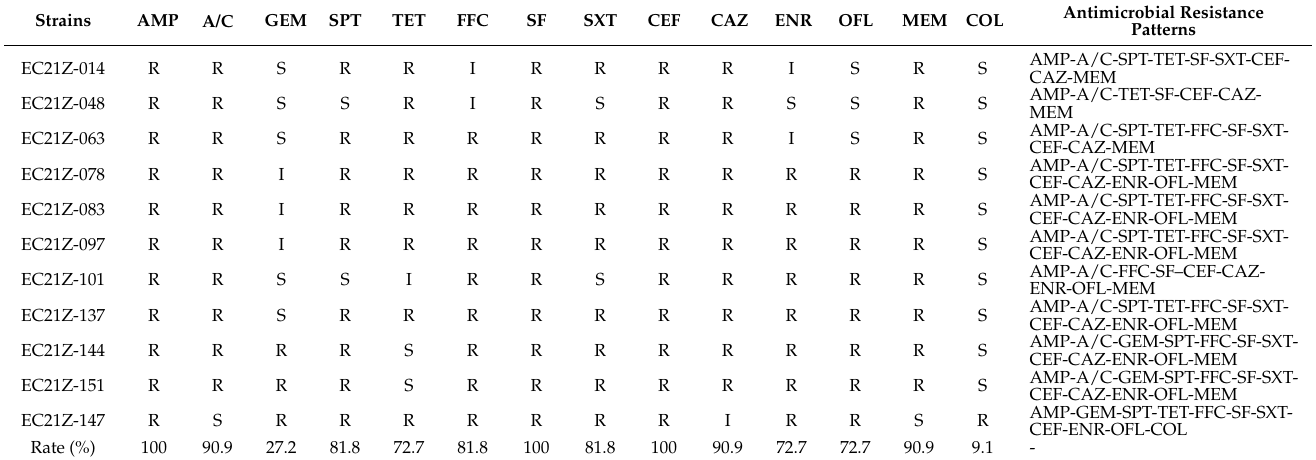
Table 2. Antimicrobial susceptibility test of 11 E. coli isolates against 14 antimicrobials.